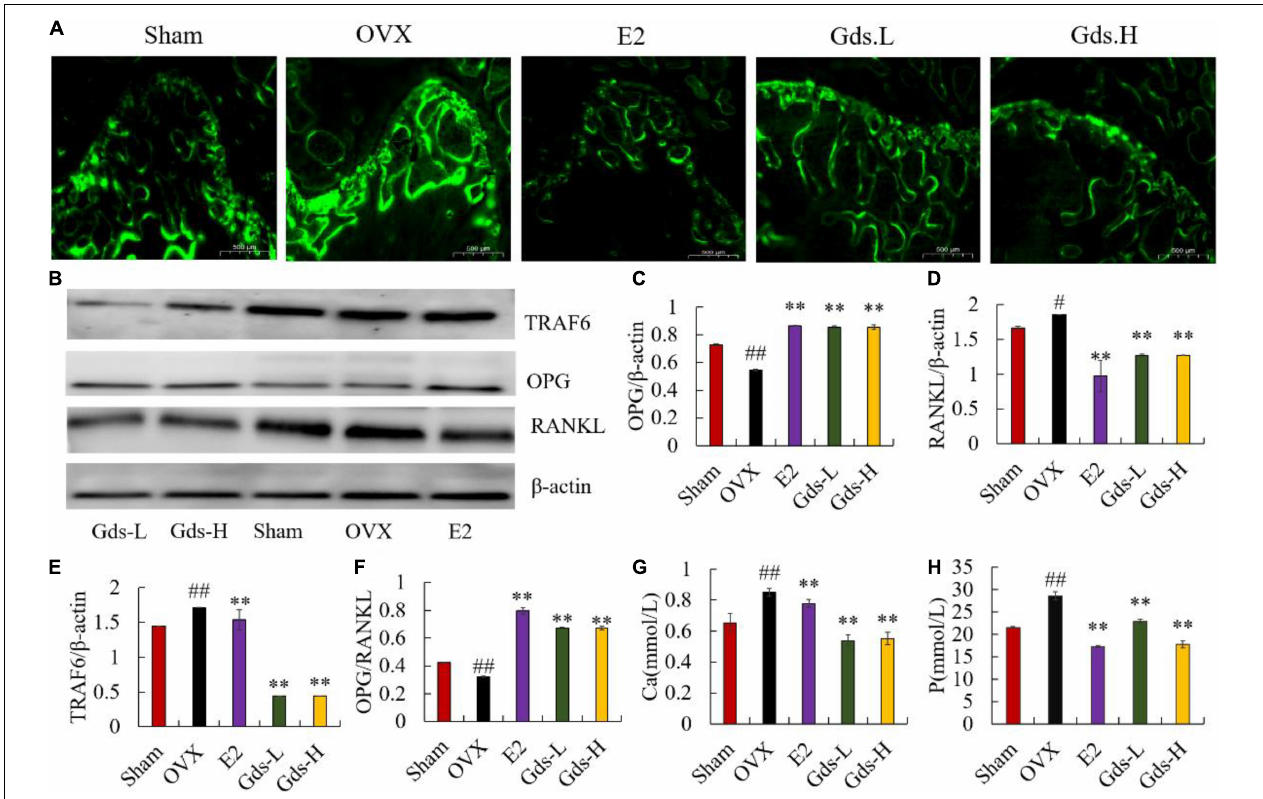
FIGURE 2 | Gds protected rats against the high bone turnover leaded by estrogen deficiency. (A) Representative fluorescence labeling results of calcein in femoral of each group; (B) the western blot image showed the expression of (E) TRAF6, (C) OPG, (D) RANKL; expression of bone and the quantified content of protein were analyzed by ImageJ. (F) OPG/RANKL, (G) Ca, the amount of Ca ions in urine (mmol/L), (H) P, the amount of P ions in urine. Sham, sham operated group; OVX, ovariectomized control group; Gds-L, low dose of Gadus morhua sialoglycoprotein-treated group; Gds-H, high dose of Gadus morhua sialoglycoprotein-treated group; E2, positive drug control group. Ave ± SE, # p < 0.05, ## p < 0.01 vs. Sham group; ∗ p < 0.05, ∗∗ p < 0.01 vs. OVX